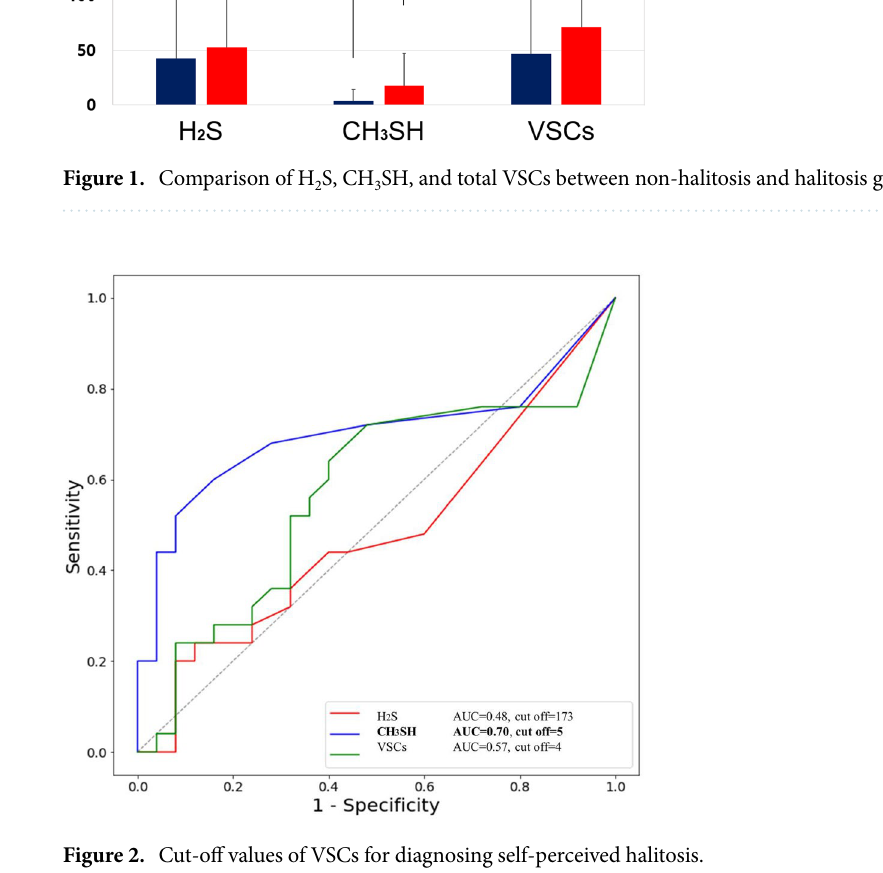
Figure 2. Cut-off values of VSCs for diagnosing self-perceived halitosis.